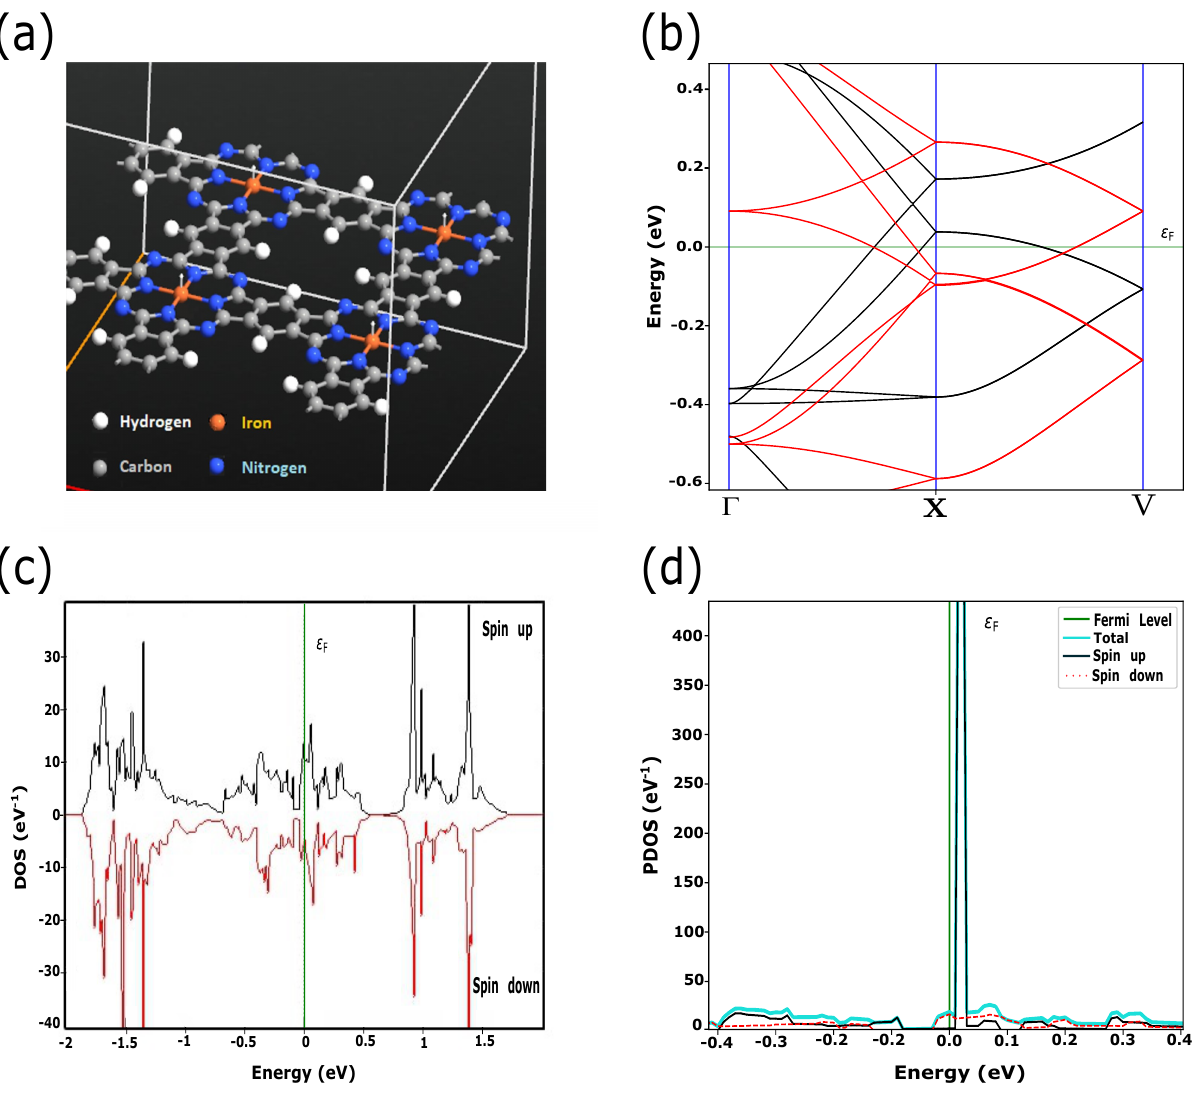
Figure 1. ( a ) FePPC supercell with parallel magnetic moments in Fe (white arrows), defined as FM ordered; ( b ) Spin up (black) and spin down (red) dispersion bands. ( c ) Spin-resolved DOS for FePPC; ( d ) PDOS, where the highest peak is formed due to spin up band